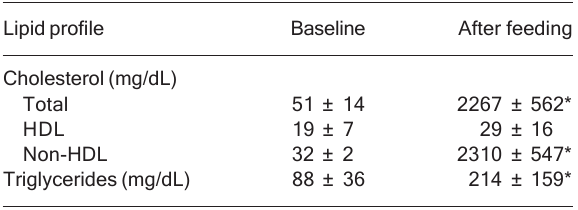
Table 1. Lipid profile of 13 rabbits with induced atherosclerosis at baseline and after cholesterol feeding.